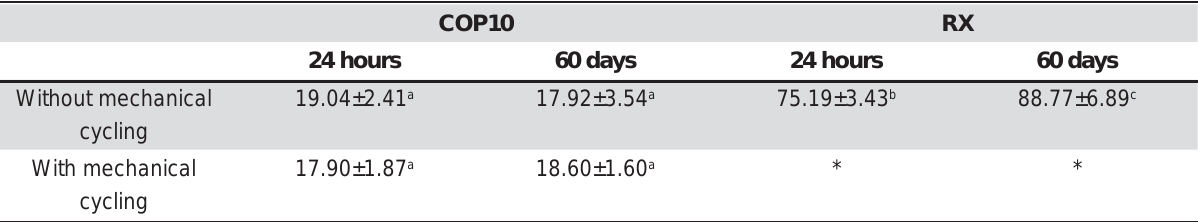
Table 1- (cid:3)(cid:48)(cid:72)(cid:68)(cid:81)(cid:86)(cid:3)(cid:11)(cid:48)(cid:51)(cid:68)(cid:12)(cid:3)(cid:68)(cid:81)(cid:71)(cid:3)(cid:86)(cid:87)(cid:68)(cid:81)(cid:71)(cid:68)(cid:85)(cid:71)(cid:3)(cid:71)(cid:72)(cid:89)(cid:76)(cid:68)(cid:87)(cid:76)(cid:82)(cid:81)(cid:86)(cid:3)(cid:82)(cid:73)(cid:3)(cid:192)(cid:72)(cid:91)(cid:88)(cid:85)(cid:68)(cid:79)(cid:3)(cid:86)(cid:87)(cid:85)(cid:72)(cid:81)(cid:74)(cid:87)(cid:75)(cid:3)(cid:89)(cid:68)(cid:79)(cid:88)(cid:72)(cid:86)(cid:3)(cid:82)(cid:73)(cid:3)(cid:79)(cid:88)(cid:87)(cid:76)(cid:81)(cid:74)(cid:3)(cid:68)(cid:74)(cid:72)(cid:81)(cid:87)(cid:86)(cid:3)(cid:68)(cid:70)(cid:70)(cid:82)(cid:85)(cid:71)(cid:76)(cid:81)(cid:74)(cid:3)(cid:87)(cid:82)(cid:3)(cid:86)(cid:87)(cid:82)(cid:85)(cid:68)(cid:74)(cid:72)(cid:3)(cid:87)(cid:76)(cid:80)(cid:72)(cid:3)(cid:68)(cid:81)(cid:71)(cid:3) performance of mechanical cycling test